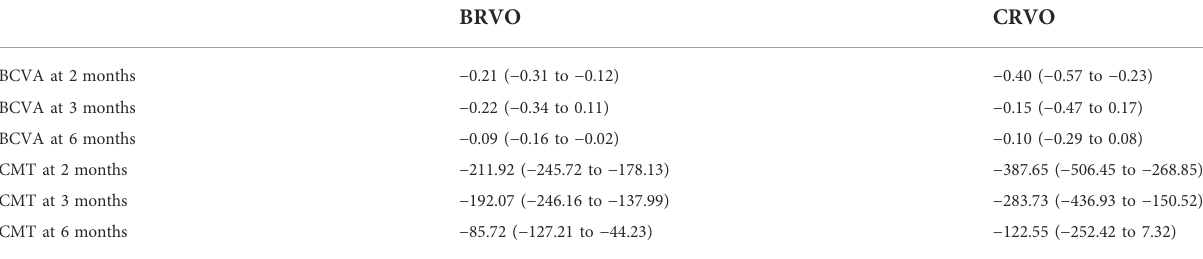
TABLE 2 Subgroup analysis of BCVA (logMAR) and CMT ( μ m) outcomes (mean and 95% con fi dence intervals). BRVO CRVO BCVA at 2 months − 0.21 ( − 0.31 to −